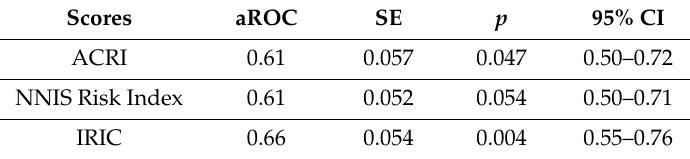
Figure 2. Comparisons of aROC corresponding to IRIC, NISS risk index and ACRI to evaluate di ff erences between these scoring systems (test sample). ACRI, Australian Clinical Risk Index; aROC, area under the Receiver-Operating Characteristic curve; CI, confidence interval; IRIC, Infection Risk Index in Cardiac surgery; NNIS, National Nosocomial Infections Surveillance. Table 5. Calculation of discrimination for the compared scoring systems (test